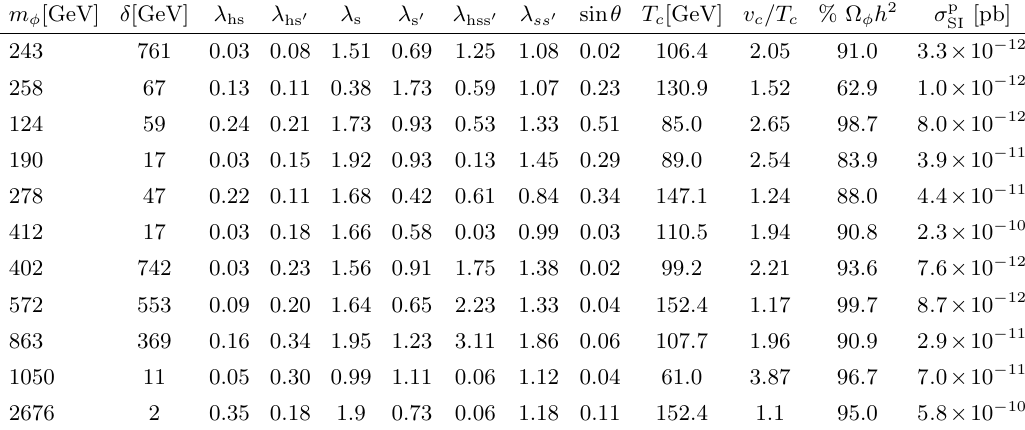
Table 4 . Benchmarks for scenario 2.2.3 in the model with the s - s 0 cross-coupling